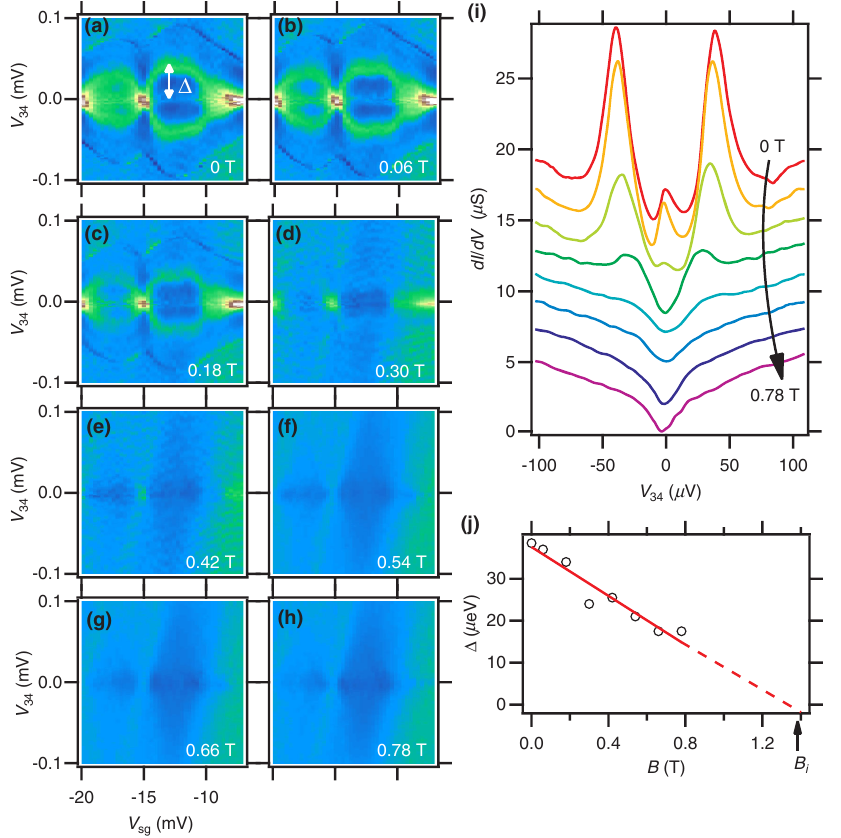
FIG. 6. Low-field dependence of ABS. (a) – (h) ABS loops at B ¼ 0 , 0.06, and 0.18 – 0.78 T in steps of 0.12 T. (i) Average vertical line < − 11 mV). Curves are shifted for clarity. (j) Extracted pairing gap size as function of B cuts (averaged in − 14 < V sg